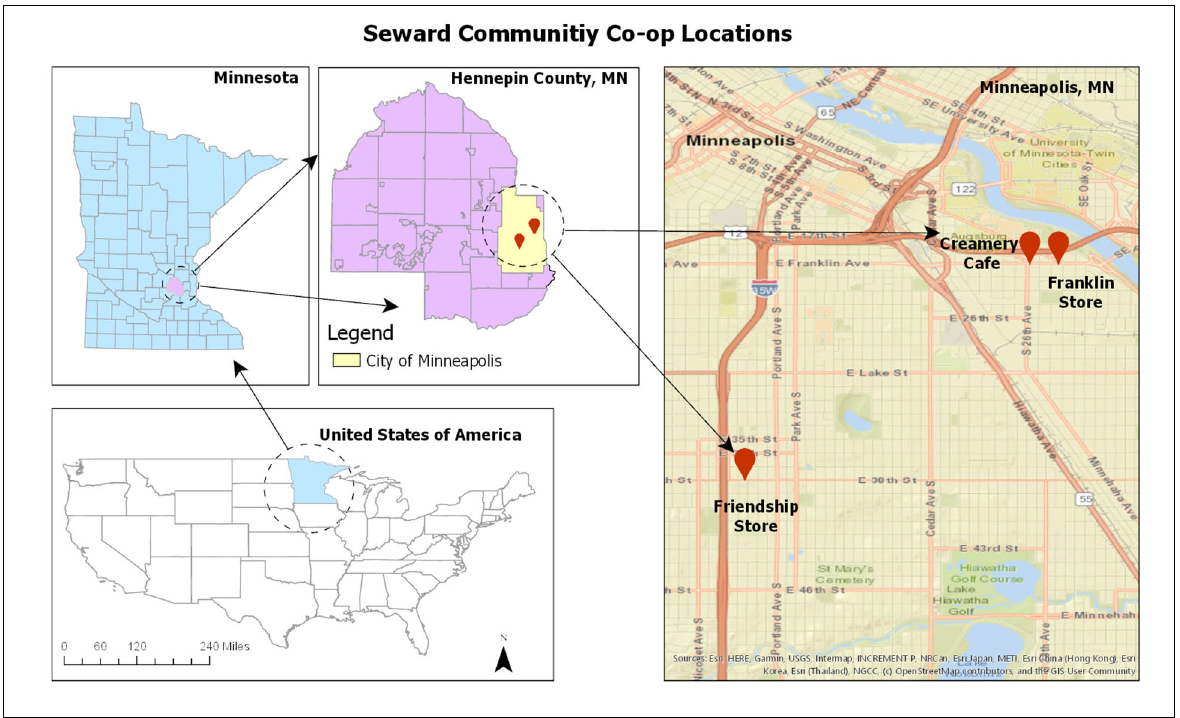
Figure 2. Locations of the Seward Cooperatives (Seward Community Co-op, the Franklin Store; Creamery Café; and the Friendship Store)